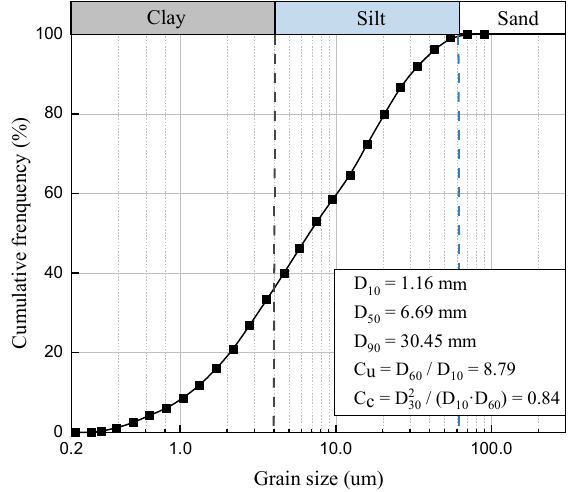
Figure 2. Grain size distribution (modified on [36,37]).